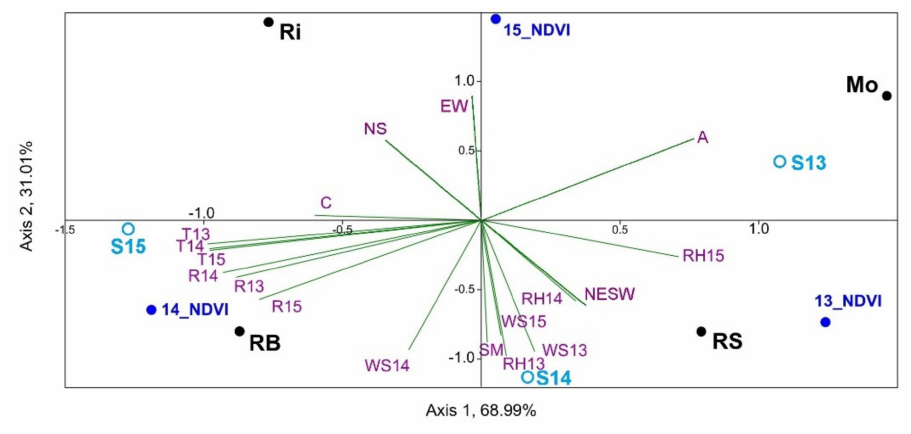
Figure 7. CCA of the influence of climatic factors, altitude, orientation, canopy, and soil management on the NDVI concerning the different AOPs during the three consecutive years examined. Factors: T, monthly average temperature; C canopy; R, monthly average rainfall; WS, monthly average wind speed; SM, soil management; RH, monthly average relative humidity; A, altitude; NS, north–south orientation; EW, east–west orientation; NESW, northeast–southwest orientation. S13, S14, and S15: yeast species richness in 2013, 2014, and 2015,